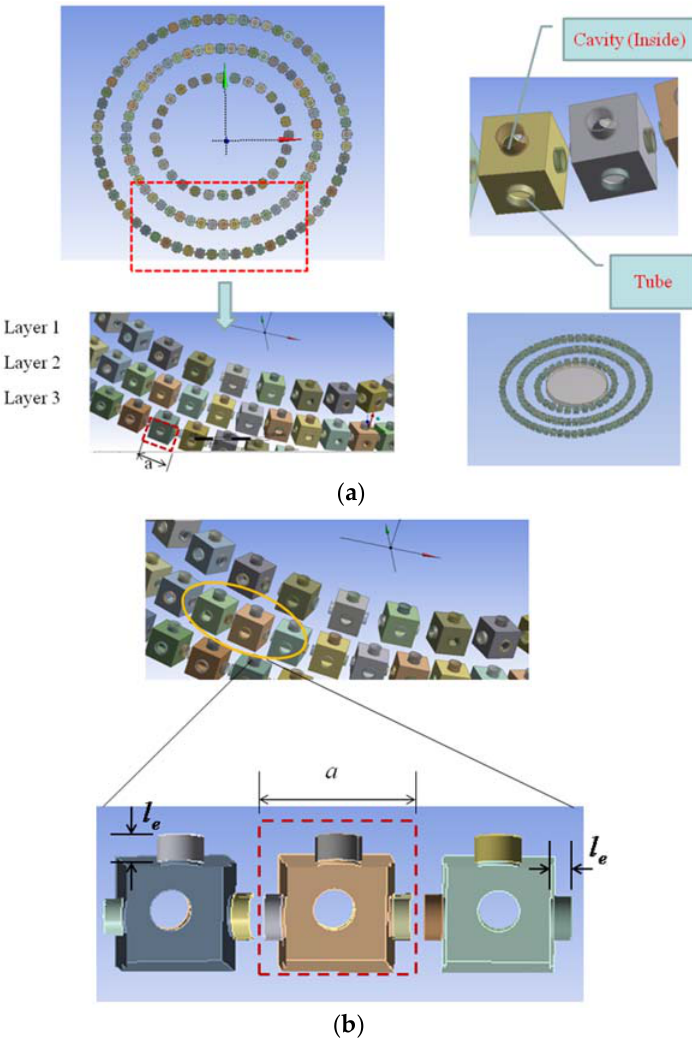
Figure 7. Structure of the meta ‐ composite material used to make up the cloak shell: ( a ) the block elements include cavities and tubes arranged as circular elements in three layers. The inset on the upper right shows the details of single block elements with rectangular cavities and tubes. The bottom right inset exhibits both the cloak shell layered structures and cylinder object inside the cloaked region; ( b ) the part slices of the meta ‐ composite material layer exhibit the interior cavity and tube in directions. The coefficient a explains the cross section dimension of and individual element, and e l represents the effective lengths of the tube connected with the cavity.